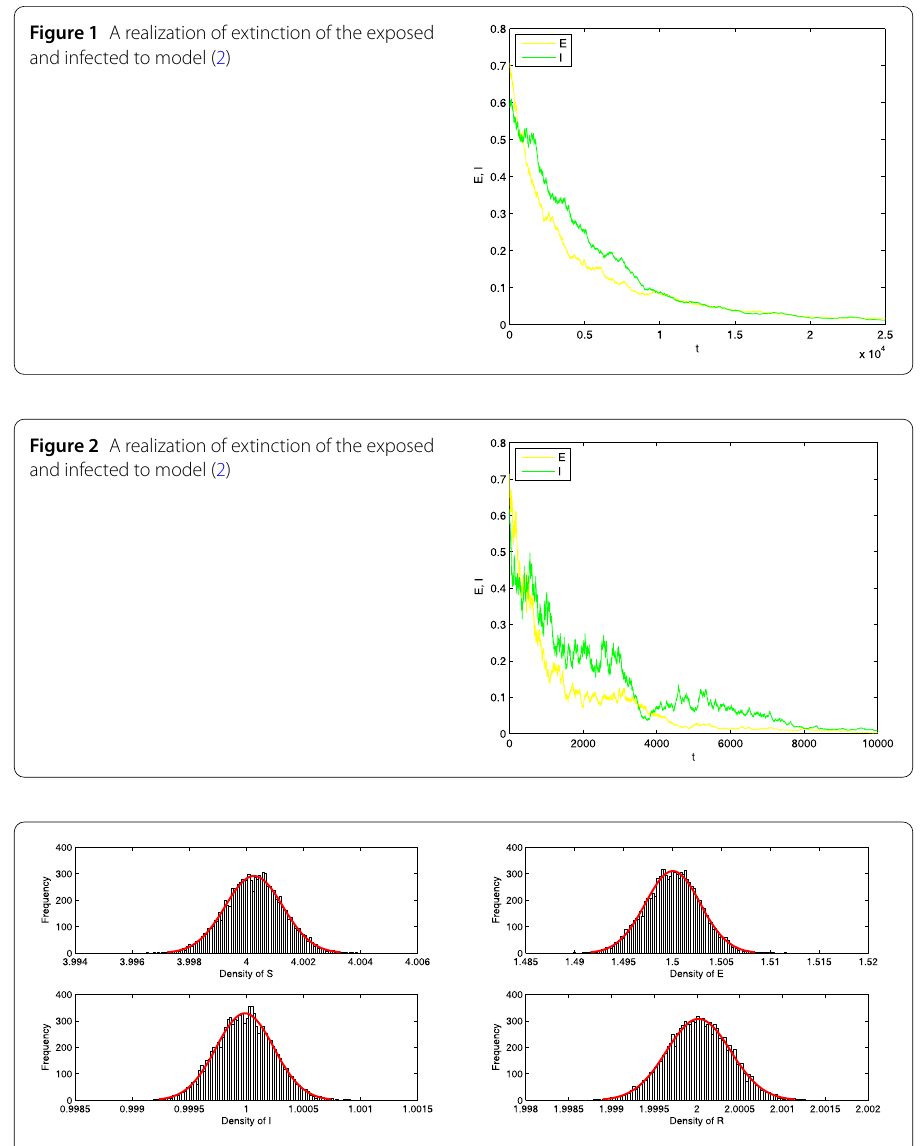
Figure 3 Histogram of the susceptible, the exposed, the infected, and the recovered to model